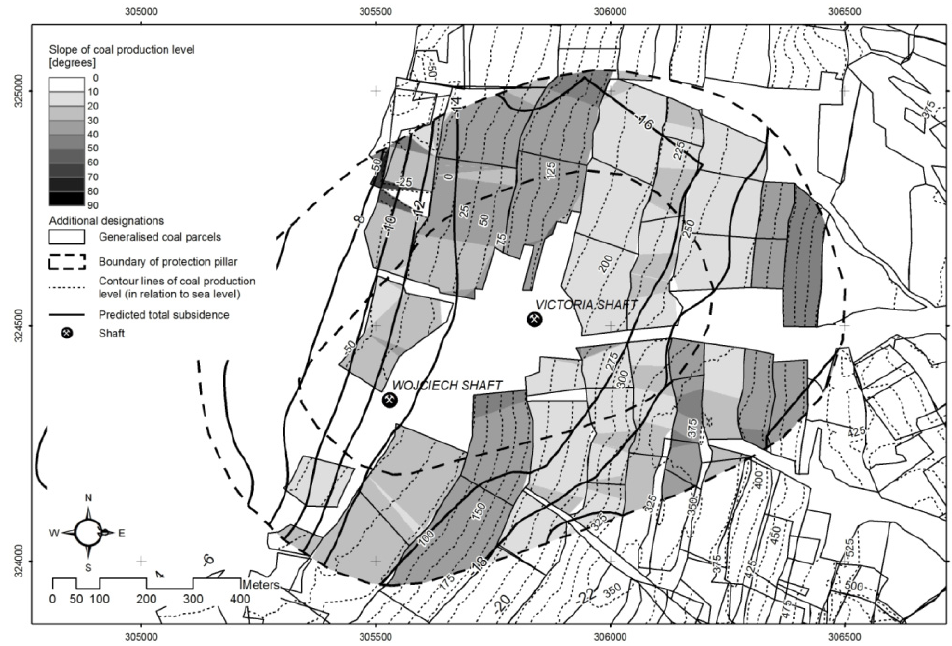
Figure 12. Subsidence analysis for the 424/425 coal production level within the boundaries of the protection